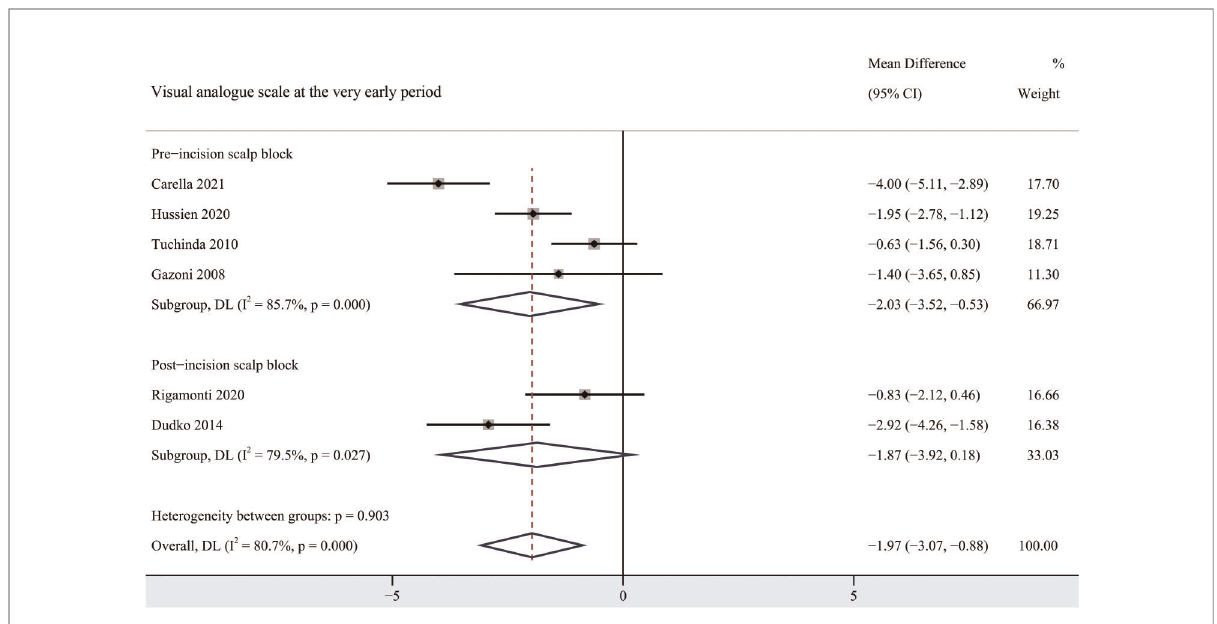
FIGURE 3 Forest plot summarizing meta-analysis of studies reporting very early pain score. Notes: The black solid rhombuses indicate the estimated mean difference for each randomized controlled trial and the extending lines indicate the estimated 95% CI of mean difference for each randomized controlled trial; The black hollow rhombuses indicate the estimated mean difference (95% CI) for patients in each subgroup or all patients included; Weights are from a random-effects analysis. Abbreviation: SB, scalp block; NSB, non-scalp block; CI, con fi dence